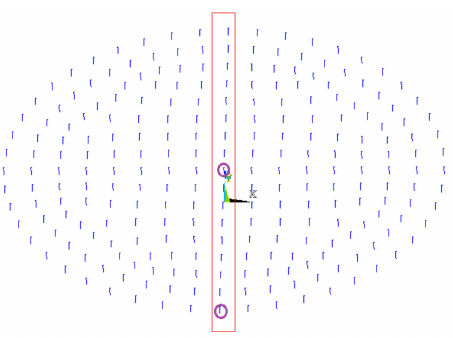
Figure 5. Layout of discrete 3D-CIBs beneath the raft foundation.